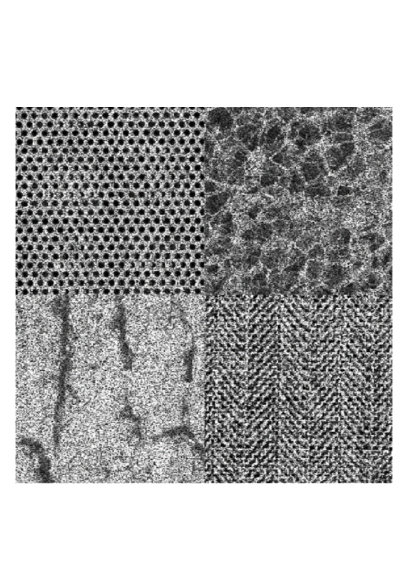
Figure 6. Autocorrelation function graph in different texture states. ( a ) is a simulated SAR image with four textures, ( b ) contains four autocorrelation function images of different textures.